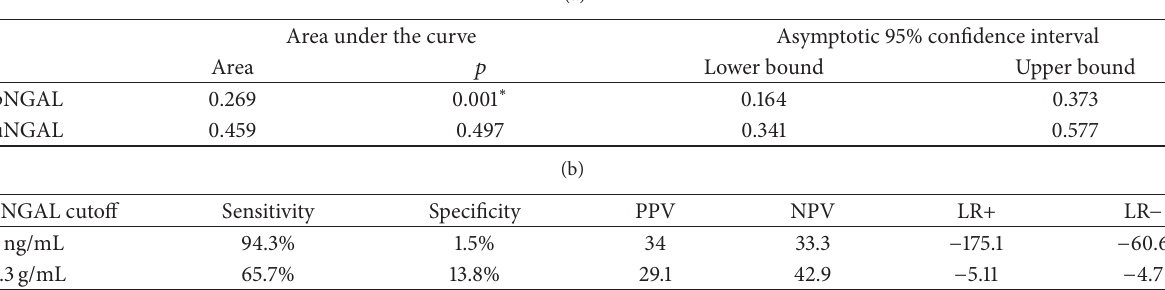
Table 3: ROC curve analysis of both pNGAL and uNGAL